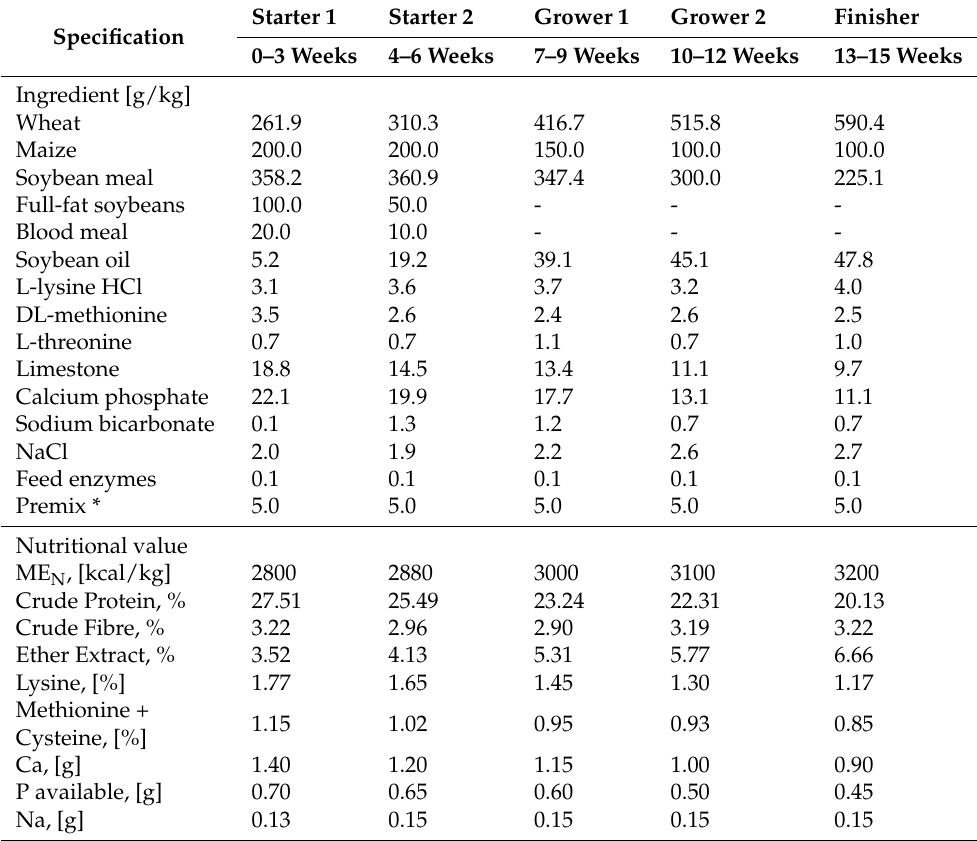
Table 1. The composition and nutritional value of turkey